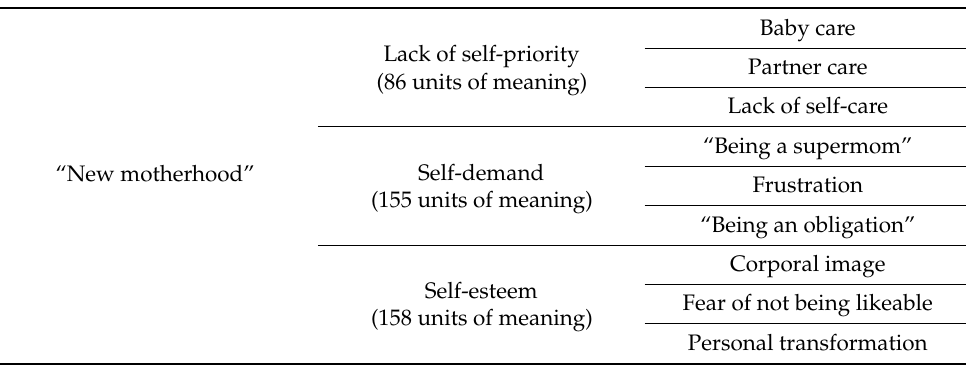
Table 3. Category “new motherhood”. “New motherhood”